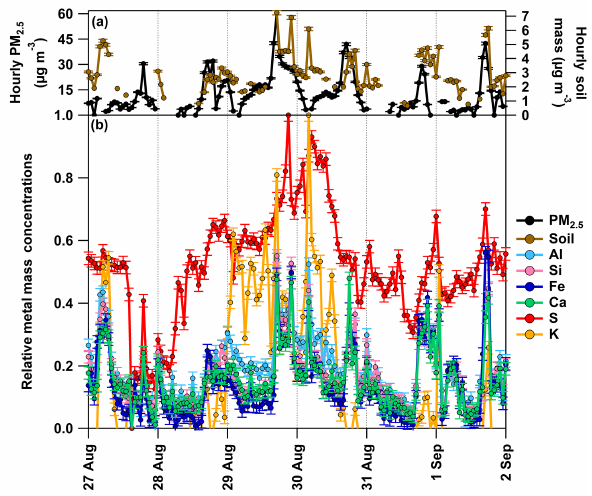
Figure 12. (a) Time series of hourly PM 2 . 5 and soil mass concentra- tions as measured by PX-375 between 27 August and 2 September 2015 and (b) hourly mass concentrations of select individual metals relative to their maximum concentration observed during the study time period, including an error of ± 2%. Only data higher than the LDLs are shown. PX-375 data overlapped with event